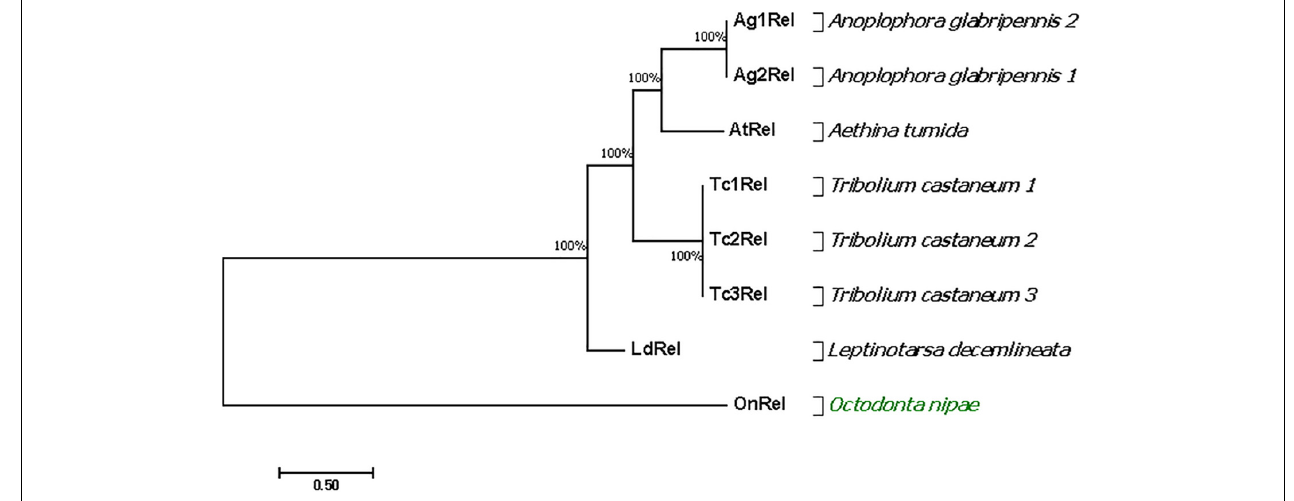
FIGURE 6 | Phylogenetic relationships of O. nipae Relish and other arthropod Relish. The amino acid sequences of the partial OnRelish proteins and complete proteins of other arthropod NF- κ B p110/Relish were aligned to construct the maximum likelihood (ML) tree using MEGA 7.0. Numbers indicate the percentage of bootstrap replications that support each branch.